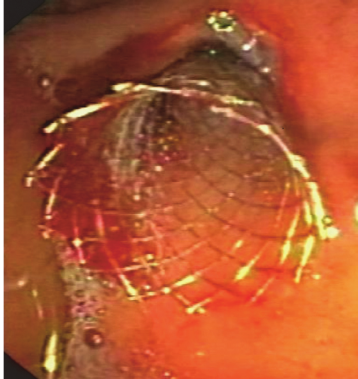
Figure 4: The metallic stent is placed.